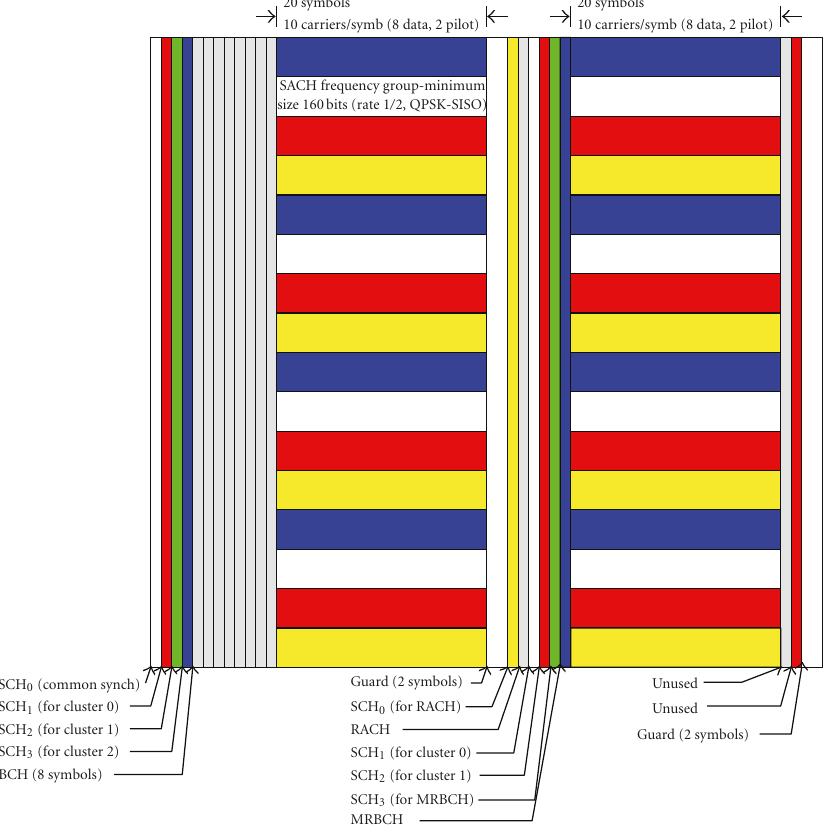
Figure 5: OpenAirMesh frame